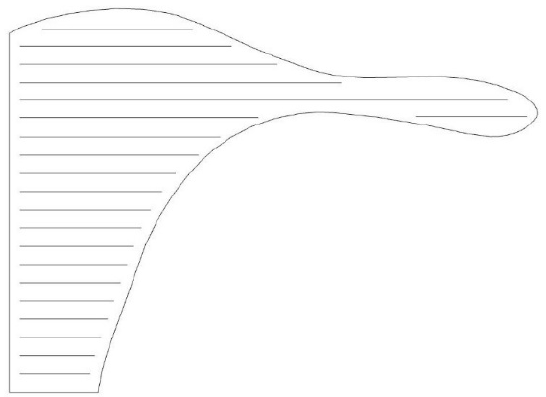
Figure 10. Robot path of the first layer of the Case Study Demonstrator.